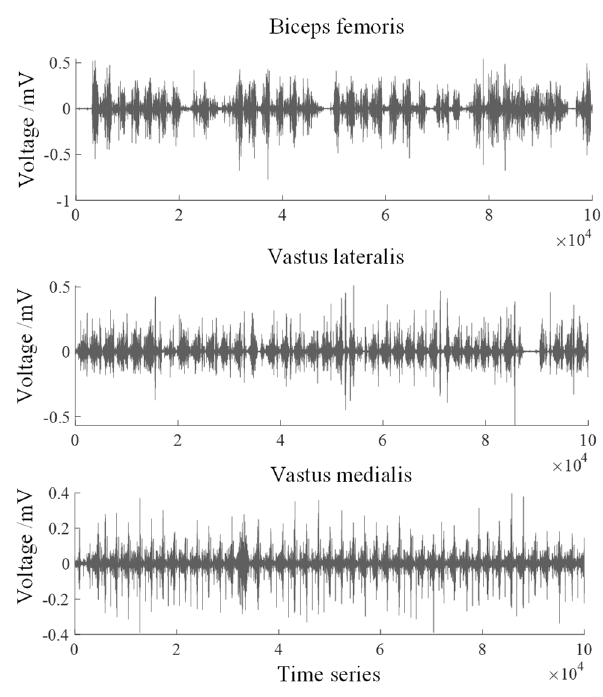
Figure 2. Filtered surface EMG signal for each